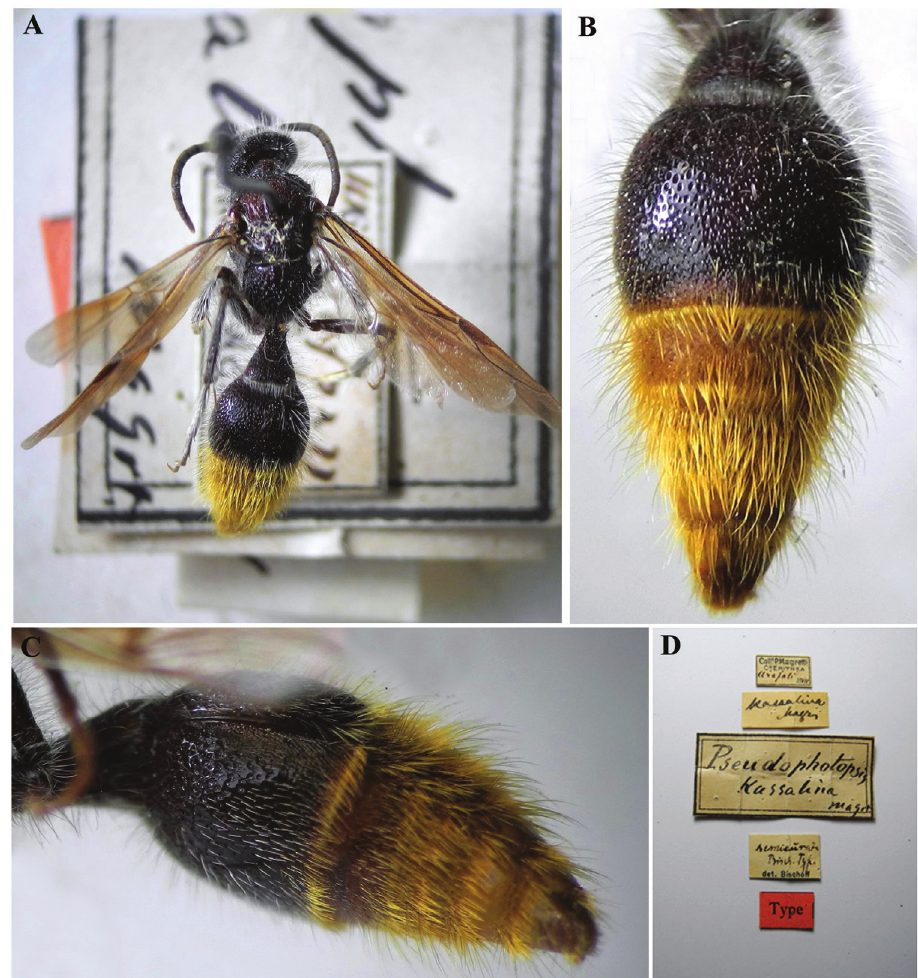
Figure 10. Pseudophotopsis aurea (Klug) (“Holotype” male of P . kassalina f. semiaurata Bischoff (MSNG)) A habitus, dorsal view B metasoma, dorsal view C metasoma, latero-ventral view D labels.